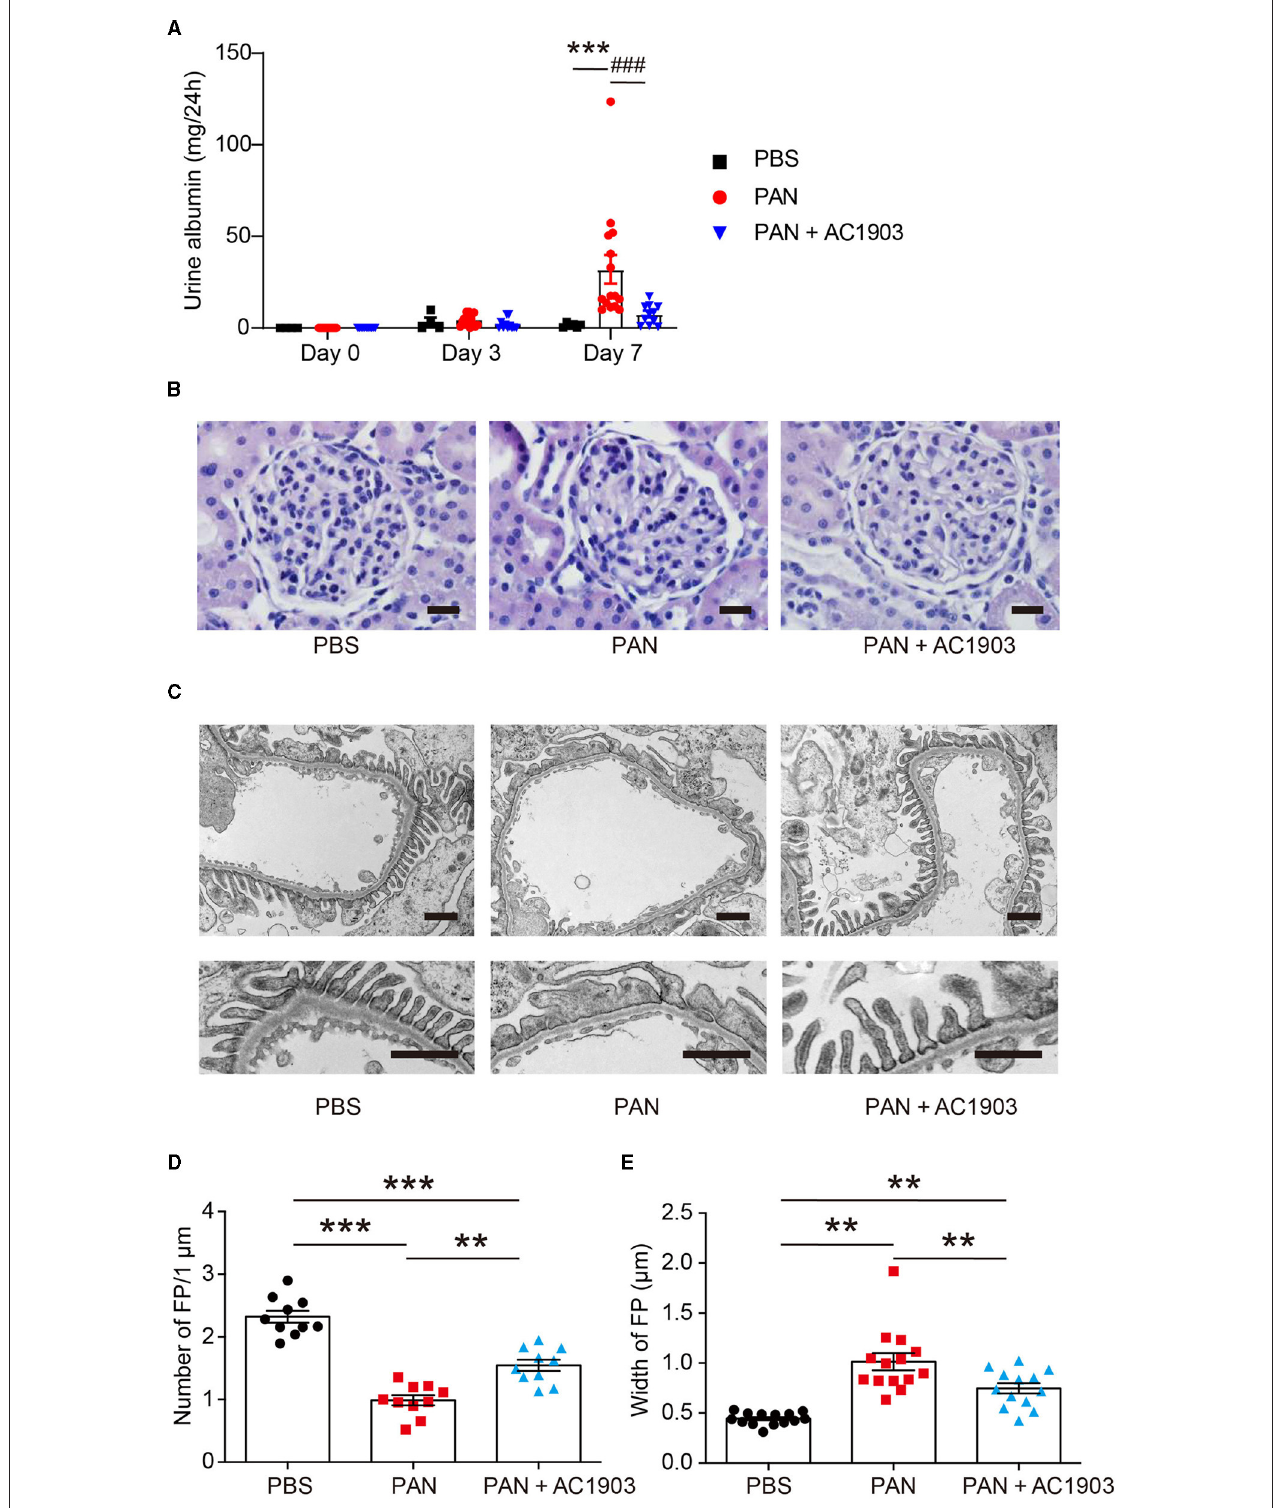
FIGURE 1 | AC1903 reduces proteinuria and protects podocytes from injury in a PAN nephrosis rat model. (A) 24-h urine albumin levels from PBS, PAN and PAN + AC1903 treated rats on day 0, 3 and 7. PAN 50 mg/kg, AC1903 50 mg/kg. PBS n = 6; PAN n = 15; PAN + AC1903 n = 13. *** p < 0.001 PBS vs PAN, ### p < 0.001 PAN vs PAN + AC1903. (B) Representative PAS staining images of PBS, PAN and PAN + AC1903 treated rats on day 7. Scale bar 20 µ m. (C) Representative TEM images of podocyte foot processes (FPs) from PBS, PAN and PAN + AC1903 treated rat on day 7. Scale bar 1 µ m. (D,E) Quantification of podocyte FPEs using the FP number (D) and width (E) on 1 µ m glomerular basement membrane from PBS, PAN and PAN + AC1903 treated rats on day 7. ** p < 0.01, *** p < 0.001.